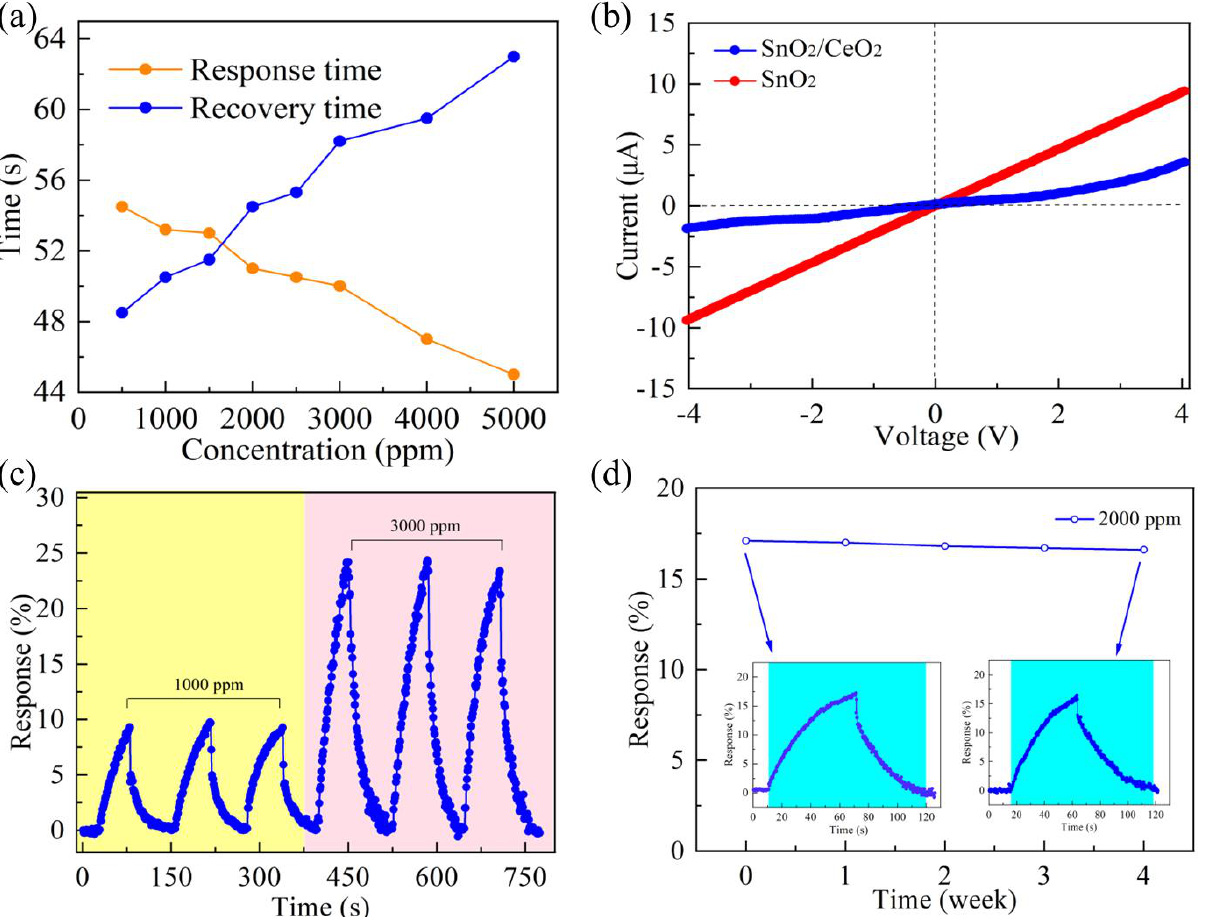
Figure 6. ( a ) Response vs. recovery time of the SnO 2 /CeO 2 composite sensor. ( b ) Current–voltage curves of the SnO 2 and SnO 2 /CeO 2 composite sensors. ( c ) Reproducibility of the SnO 2 /CeO 2 sensor toward 1000 and 3000 ppm LPG. ( d ) Long-term stability of the SnO 2 /CeO 2 composite sensor upon exposure to 2000 ppm LPG.